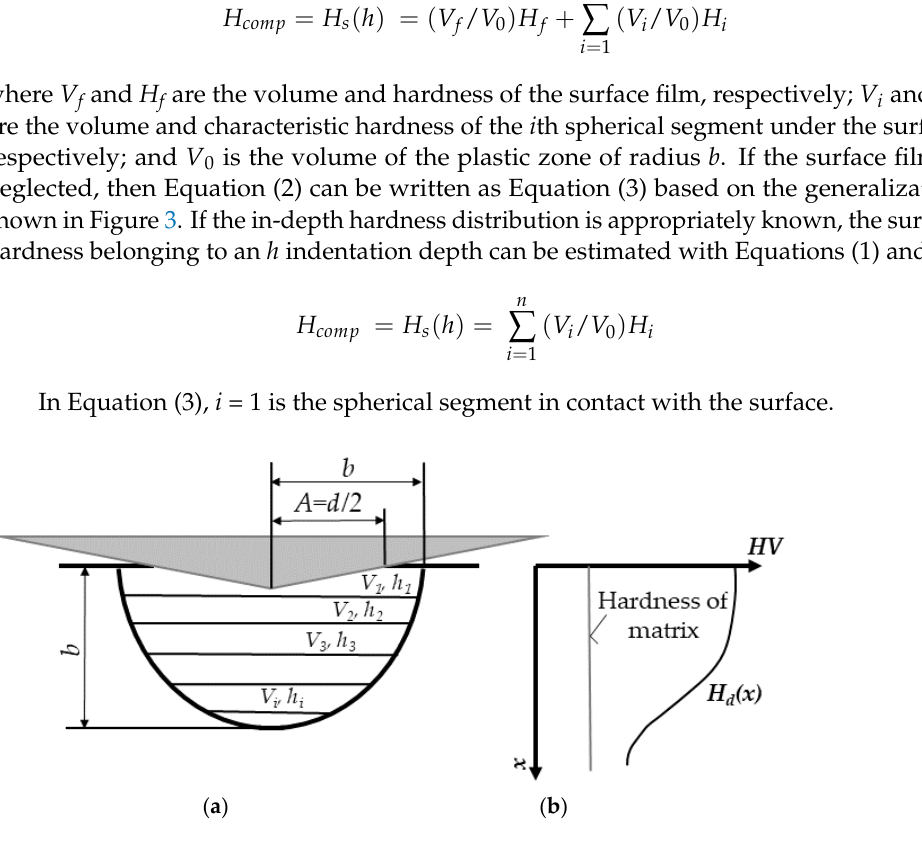
Figure 3. Interpreting composite hardness ( a ) and the hardness distribution of the layer ( b ).